Question: Generate an informative caption for the figure above.
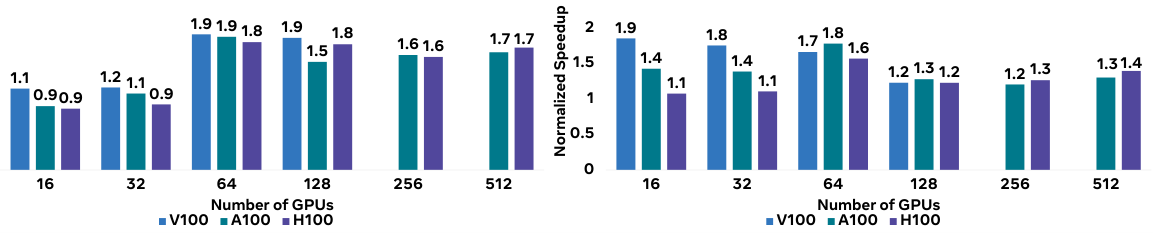
Answer: Speedup of DMT over DLRM and DCN across different hardware platforms and scales.